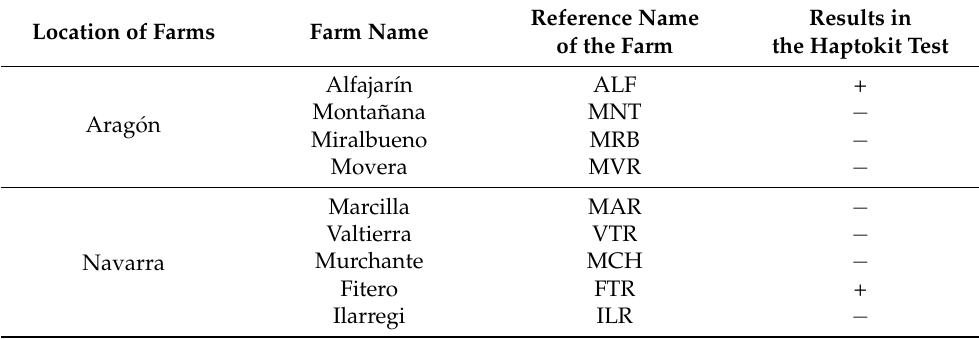
Table 2. Haptoglobin detection results in the milk tank